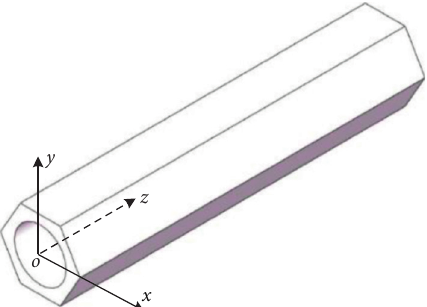
Figure 1: SAFE model of a hexagonal